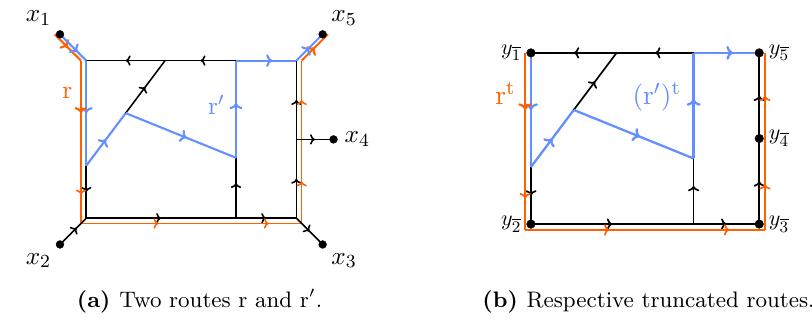
Figure 3. Illustration of the truncation of